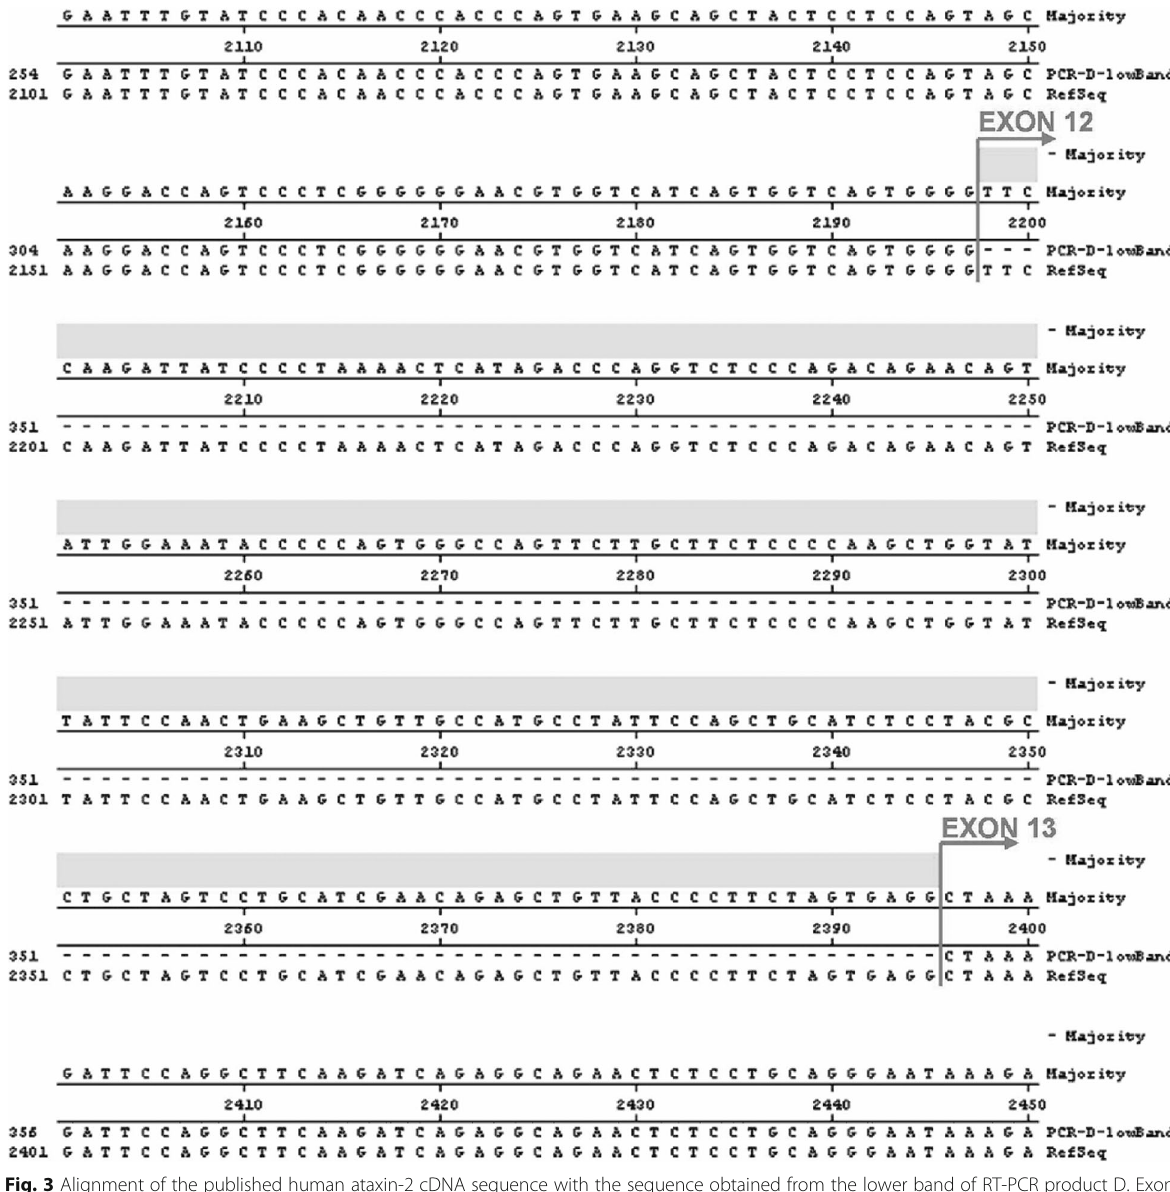
Fig. 3 Alignment of the published human ataxin-2 cDNA sequence with the sequence obtained from the lower band of RT-PCR product D. Exon 12 was